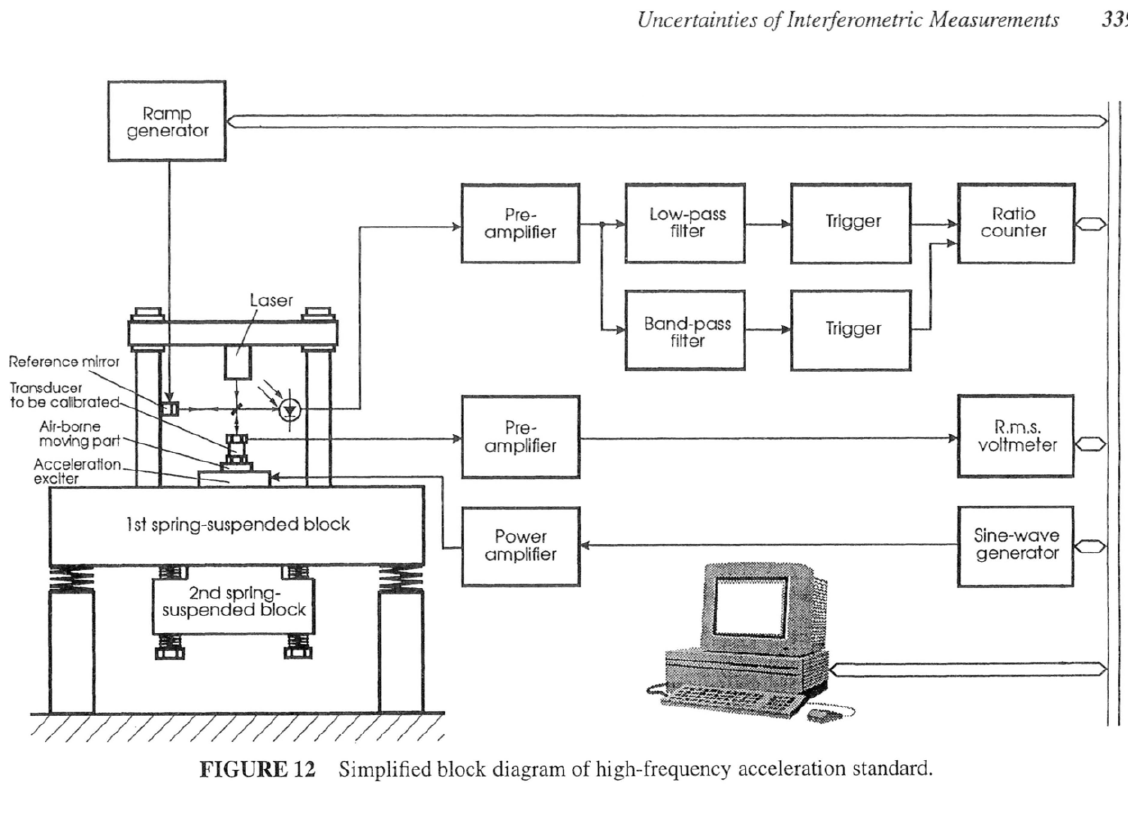
FIGURE 12 Simplified block diagram of high-frequency acceleration standard.